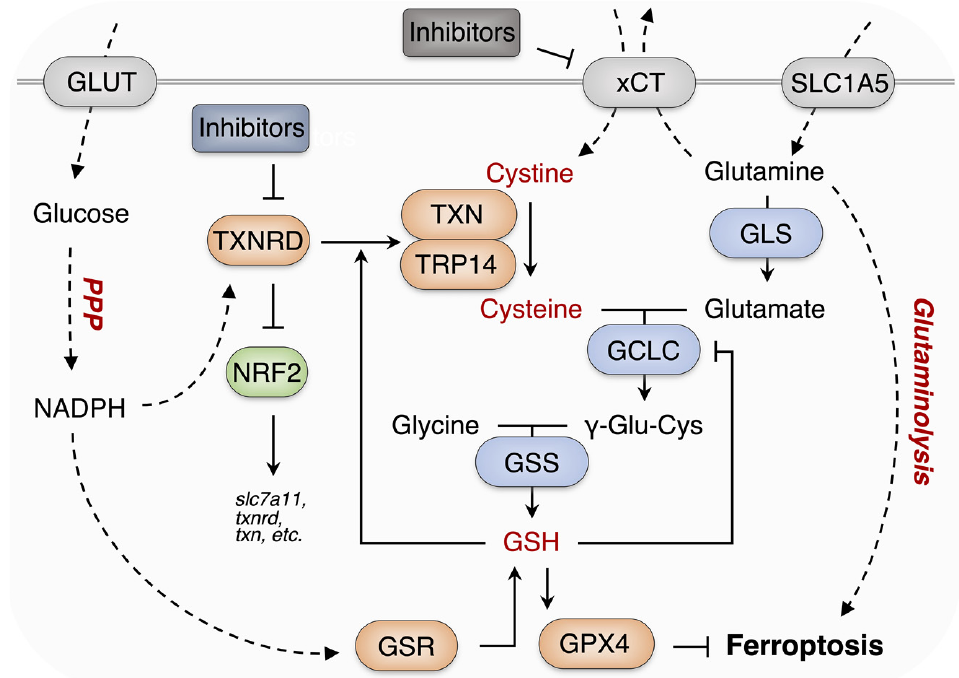
Figure 7. The proposed mechanism of pharmacological inhibition of TXNRD1 boosts the cytotoxicity of erastin in cancer cells. In mammals, TXN system and GSH system synergistically reduce cystine to cysteine, which is further used to form antioxidants GSH. So, pharmacological inhibition of TXNRD1 may confer cancer cells more sensitivity to GSH depletion or Cys starvation.